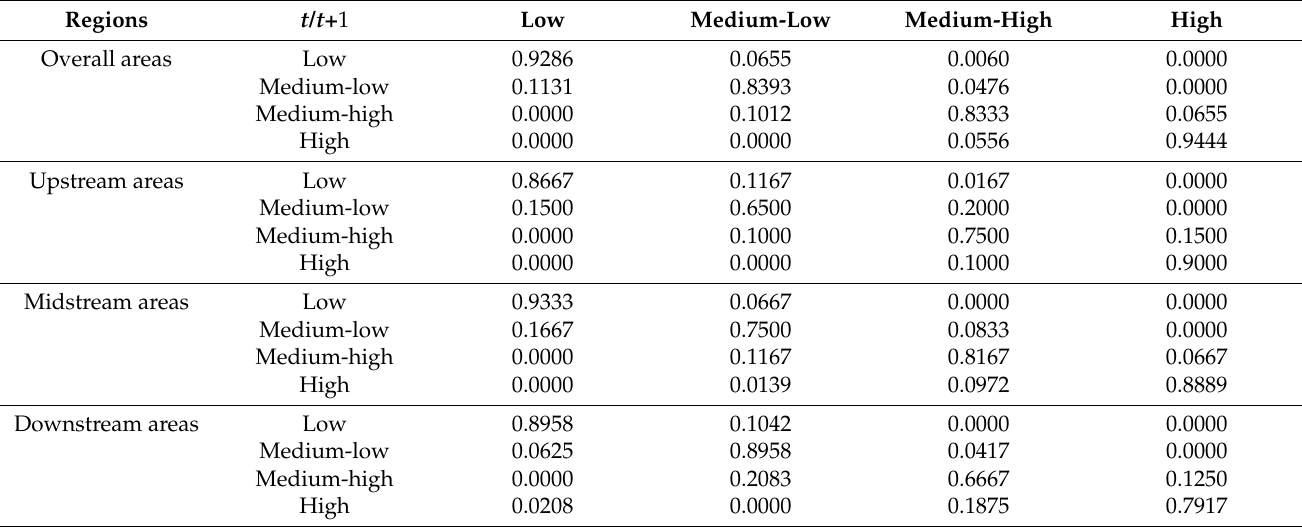
Table 3. Markov probability transfer matrix of carbon emission intensity in the